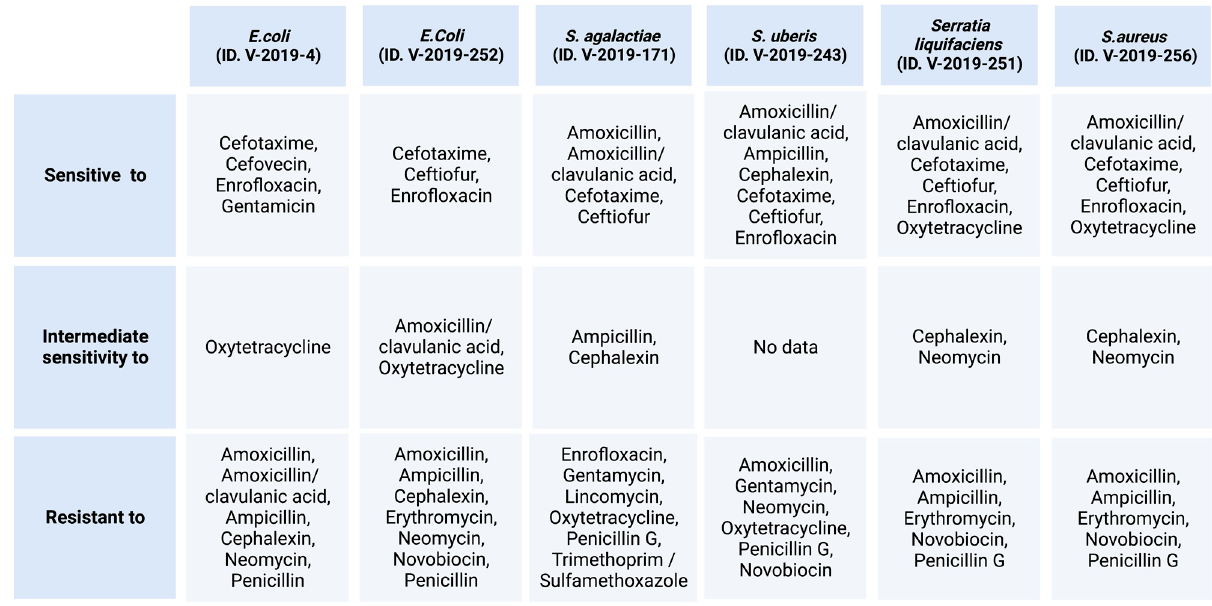
Figure 3. Antibacterial susceptibility for the bovine mastitis clinical isolates.